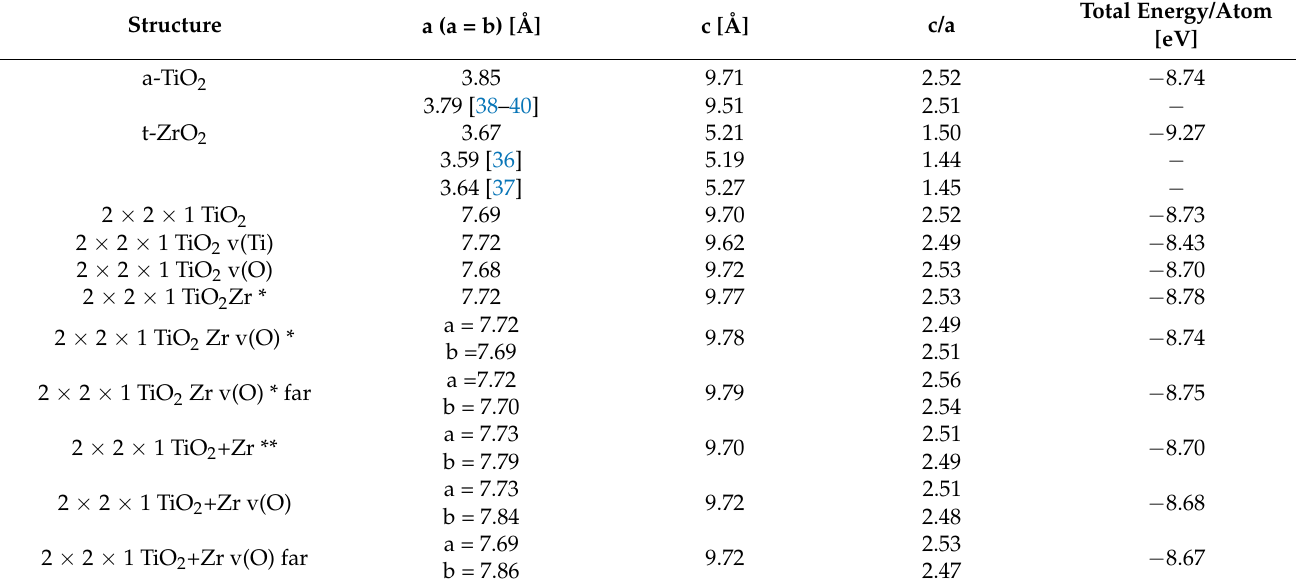
Table 2. Parameters of the unit cell of the a-TiO 2 and t-ZrO 2 stoichiometric and defected crystals obtained relaxing structure by applying DFT/PBE+U (U Ti = U Zr = 6 eV and J Ti = J Zr = 1 eV) method and compared to experimental data.